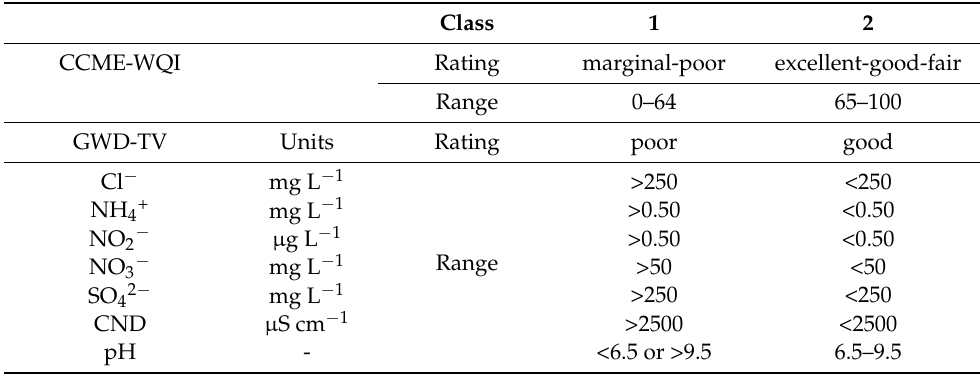
Table 2. Harmonization of CCME-WQI classes to GDW-TV classes based on guidelines provided by CCME [41,42] and European Community